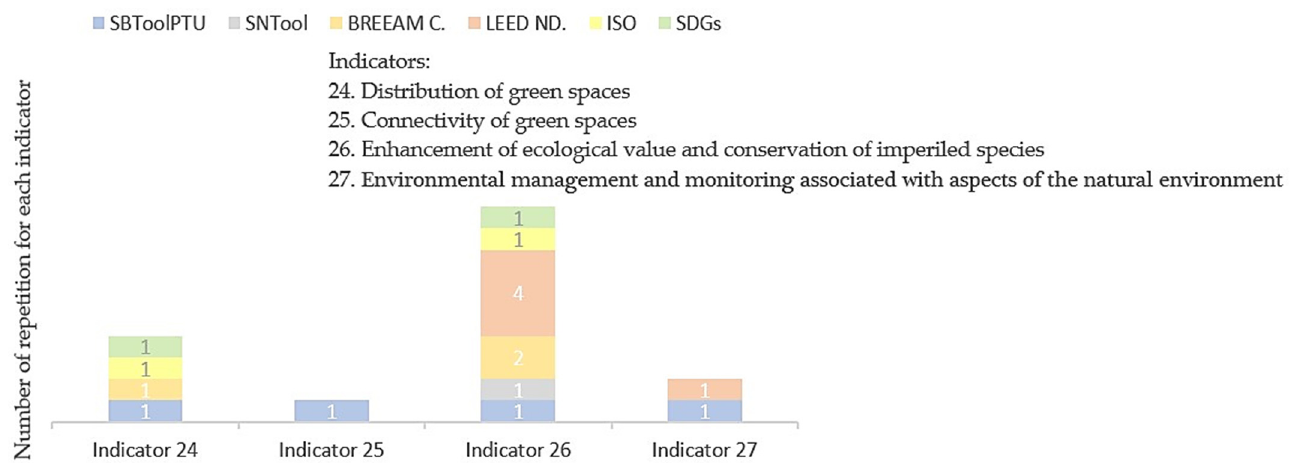
Figure 6. Frequency distribution of each indicator, relevant to the category of waste measures in SBTool PT _Urban (2018), SNTool Min (2020), BREEAM-C (2012), LEED-ND (2018), ISO 37120 and SDGs.